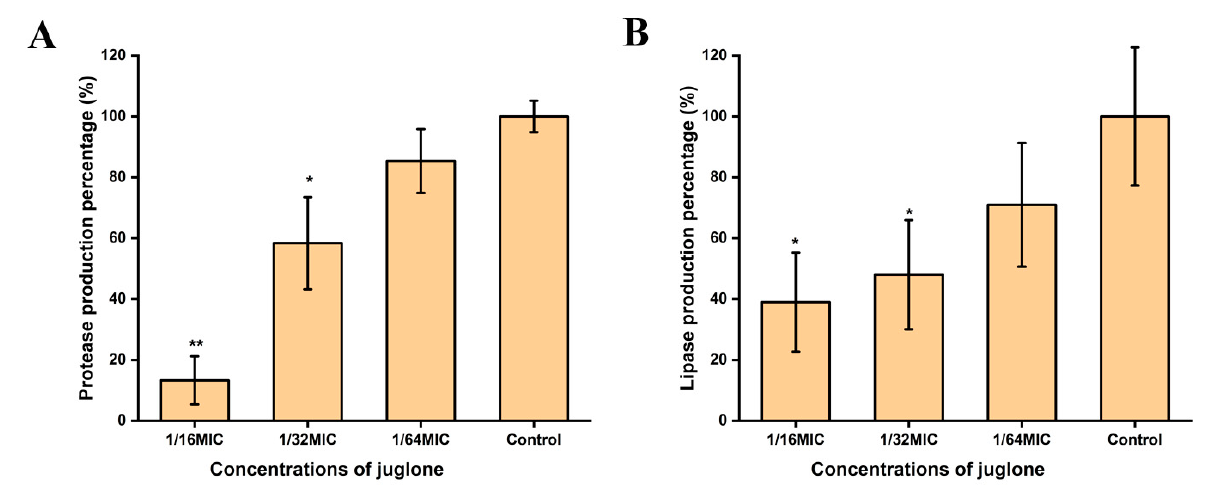
Figure 7. Juglone inhibited the expression of protease and lipase in S. aureus . ( A ) The effect of juglone on the protease secretion of S. aureus ; ( B ) the effect of juglone on the lipase secretion of S. aureus . MIC is 1000 µ g/mL. When p < 0.01, it is represented by **, when p < 0.05, it is represented by *. 2.11. Topical Juglone Treatment Accelerates the Shrinkage of Wounds Infected with S. aureus